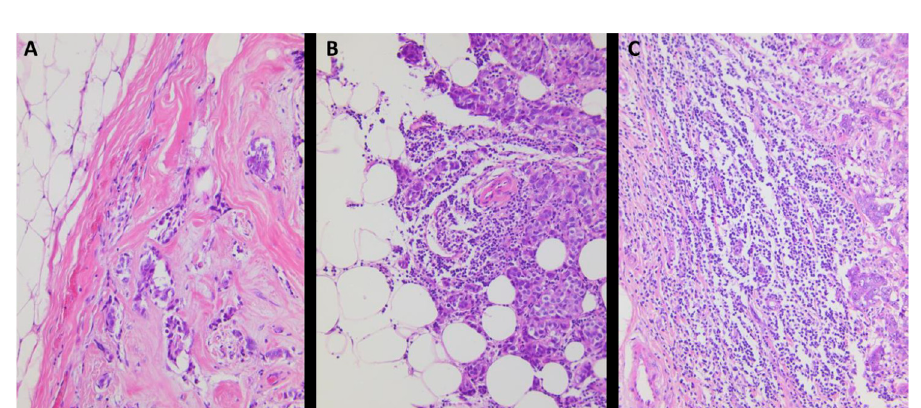
Figure 6. Examples of tumors with different levels of peritumoral inflammation according to the Klintrup score. (Panel ( A ): score 0; panel ( B ): score 1; Panel ( C ): score 2); all pictures × lens magnifi-